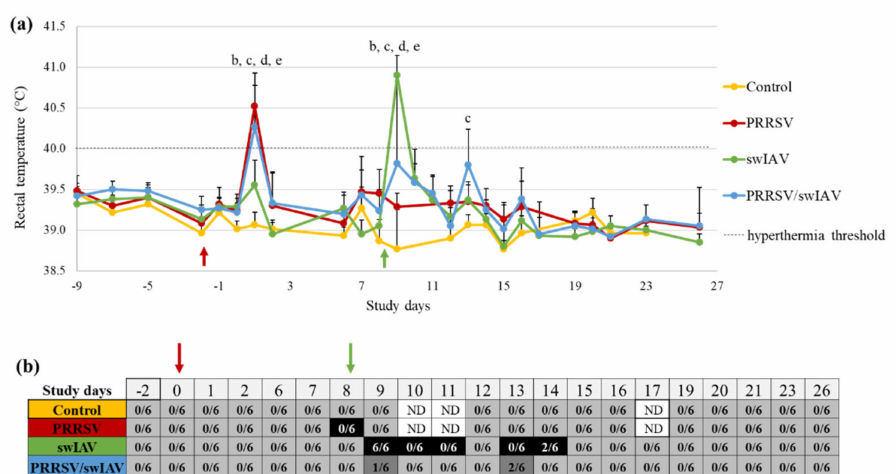
Figure 1. Clinical signs. ( a ) Rectal temperature. All data are reported as the mean ( ± standard deviation) of results obtained from pigs ( n = 6) in the PRRSV/swIAV (blue), PRRSV (red), swIAV (green) or Control (yellow) groups. Study days: SD. SD0 (red arrow): PRRSV inoculation; SD8 (green arrow): swIAV inoculation. ( b ) Respiratory signs. n /6: number of pigs with rapid breathing out of the number of pigs in the group. Black box: detection of cough, sneezing in the group and rapid breathing occasionally; Dark grey box: detection of rapid breathing only; Light grey box: no respiratory signs; ND: no data; Letters indicate that significant differences (with p < 0.05) were obtained between PRRSV/swIAV and (a) PRRSV or (b) swIAV or (c) Control groups, (d) and (e) significant difference between PRRSV or swIAV and Control groups (respectively). Only significant differences for groups exhibiting hyperthermia are shown in this